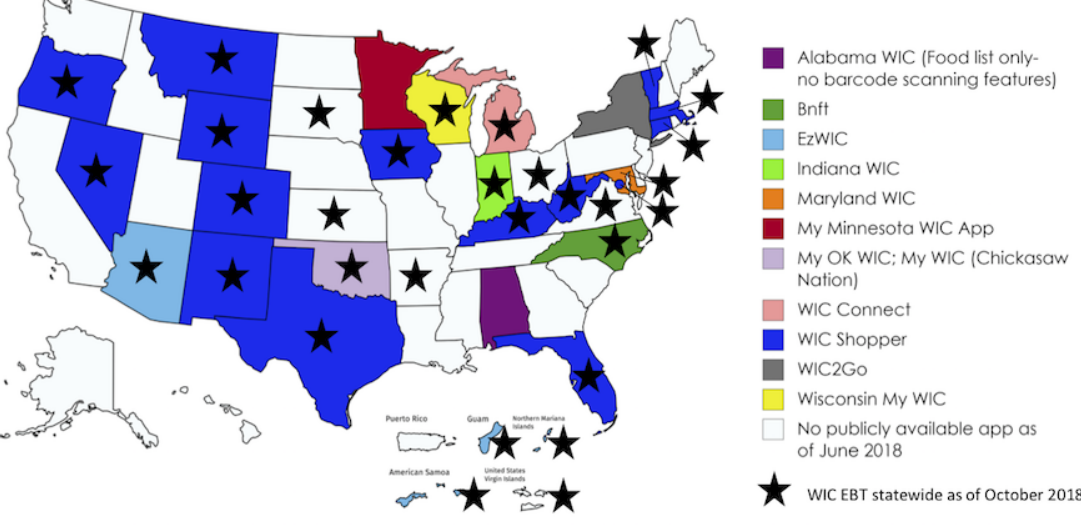
Figure 2. States and territories with shopping apps and electronic benefits transfer for Women, Infants, and Children program